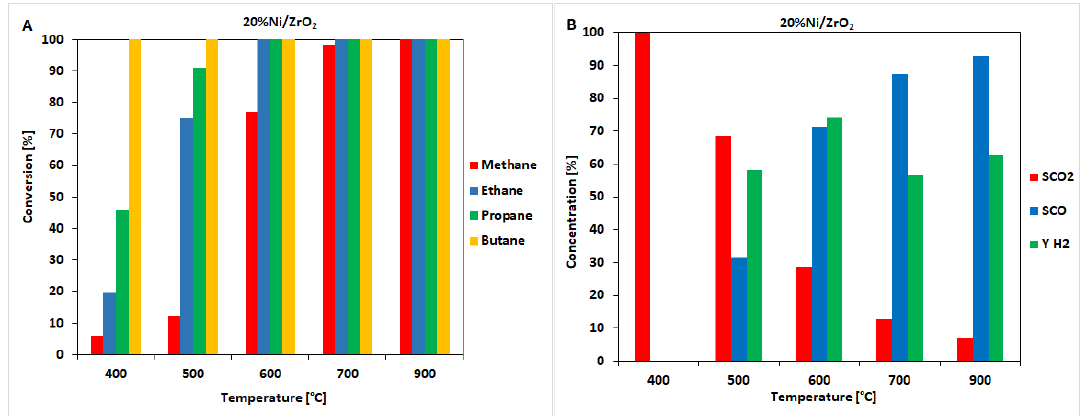
Figure 3. Results of the catalytic activity measurements performed in the temperature range 400–900 ◦ C in the OSRM of a liquified natural gas (LNG) reaction on a 20%Ni / ZrO 2 catalyst. ( A ) Hydrocarbon conversion. ( B ) The selectivity of CO and CO 2 and hydrogen yield.